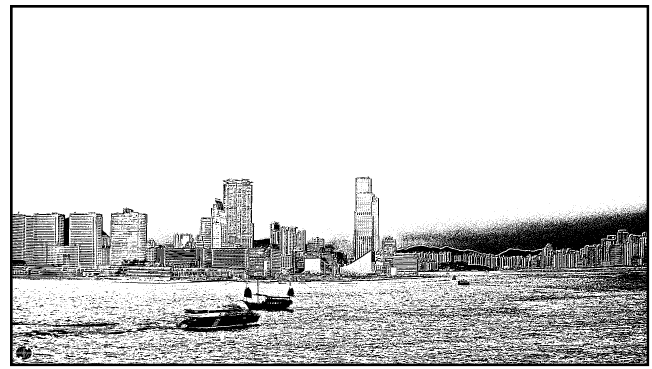
Figure 6. Comprehensive image of gray mean square error.